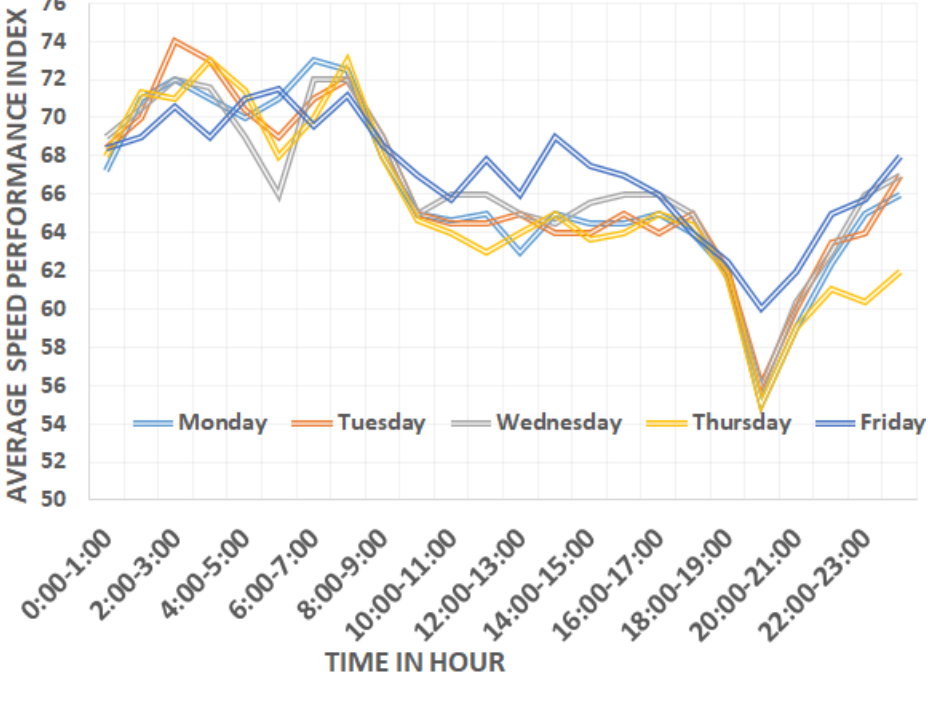
Figure 2. Speed Performance index variation on weekdays.